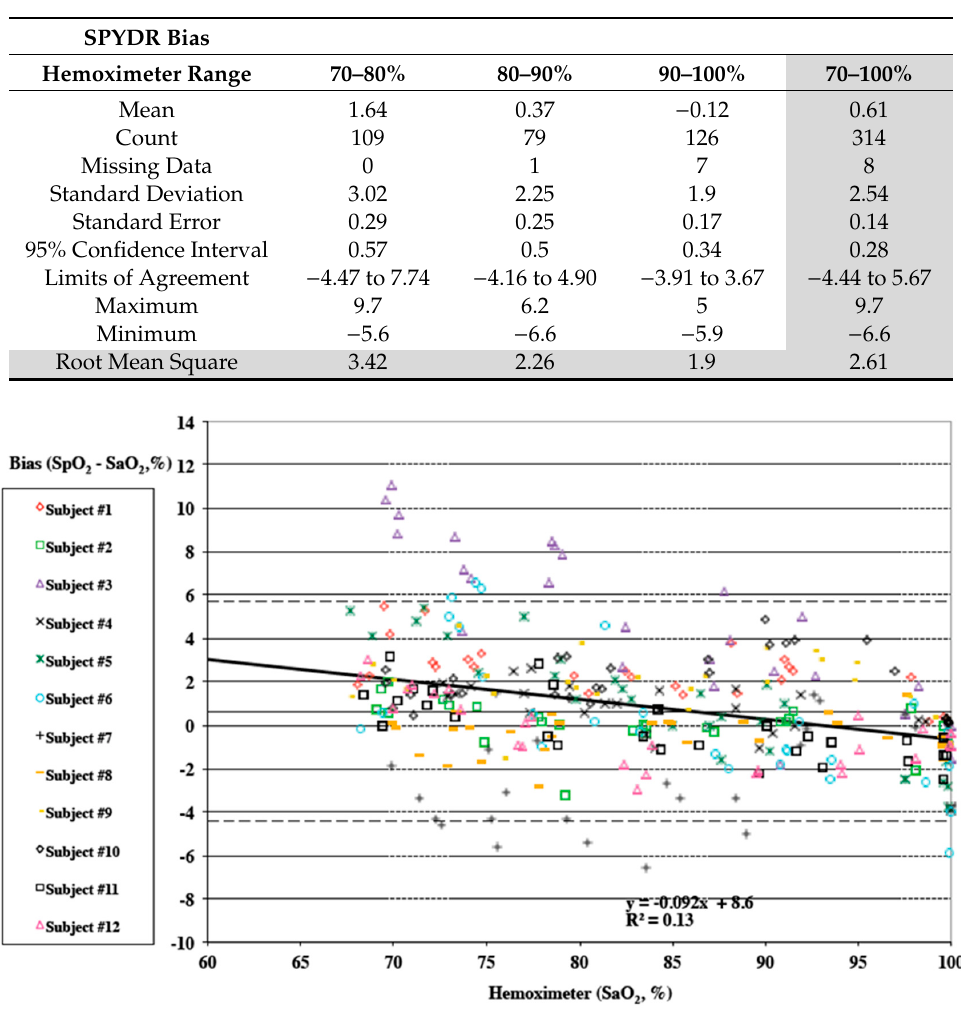
Table 3. Bias for SPYDR broken down by decadal ranges from 70–100% SaO 2 . At all ranges, SPYDR highlighted in grey. Data as presented were independently analyzed and reported by the Hypoxia